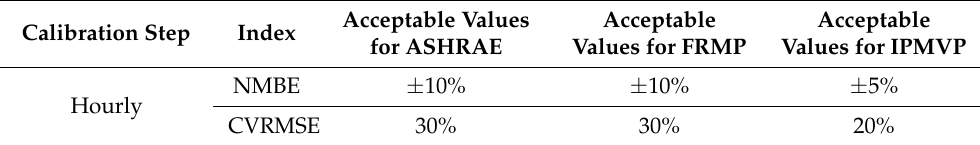
Table 4. Acceptable validation/calibration